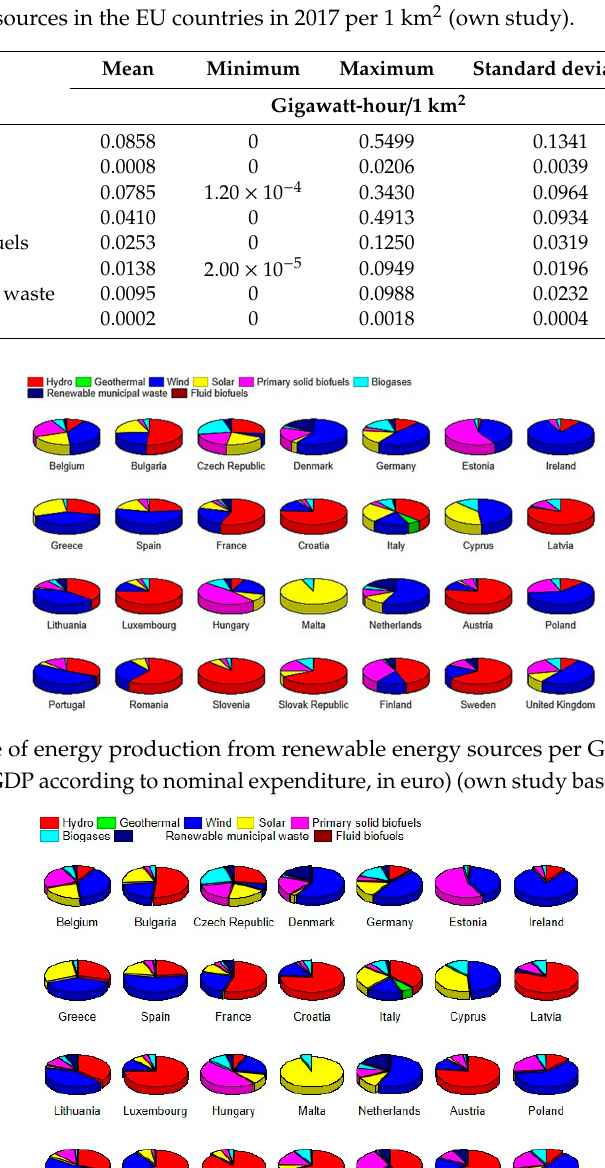
Table 3. Structure of energy production from renewable energy sources per capita of individual EU countries in 2017 (own study based on data from [37]).